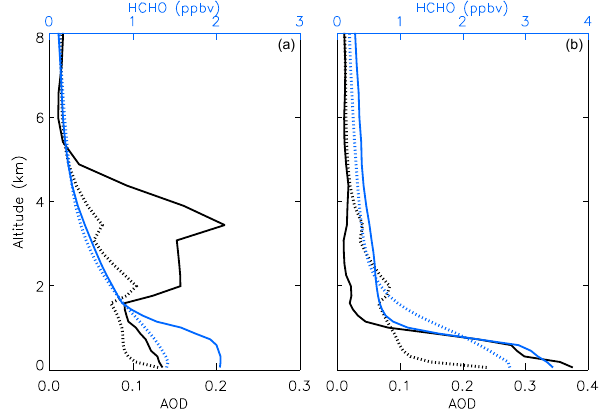
Figure 6. (a) Mean profiles of AOD (black) and HCHO (blue) over a region with decreased AMF h relative to AMF m (blue box in Fig. 5a). (b) Same as in (a) but for values over a region with increased AMF h relative to AMF m (red box in Fig. 5a). Solid and dotted lines denote hourly and monthly values,